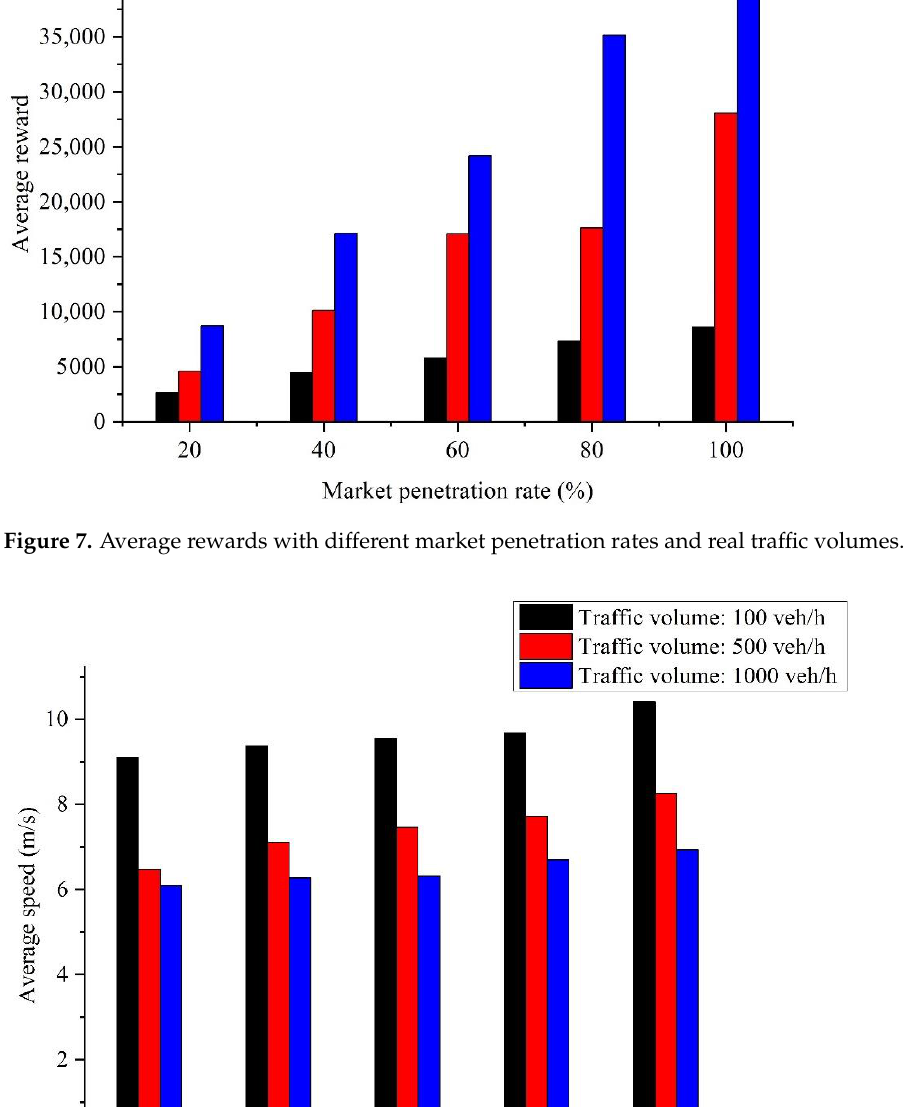
( b ) Figure 9. Emissions with different market penetration rates and real traffic volumes: ( a ) NOx; ( b ) HC.